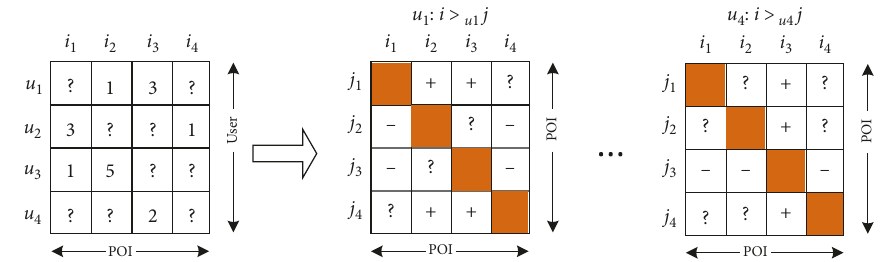
Figure 3: The reconstructing data policy from user-POI check-in matrix to pair-wise POI